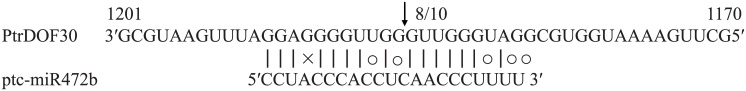
Mapping of mRNA cleavage sites confirmed by 5′ RLM-RACE.Arrows indicate the 5′ ends of the mRNA fragments, as identified by cloned 5’ RLM-RACE products, with the frequency of clones shown.